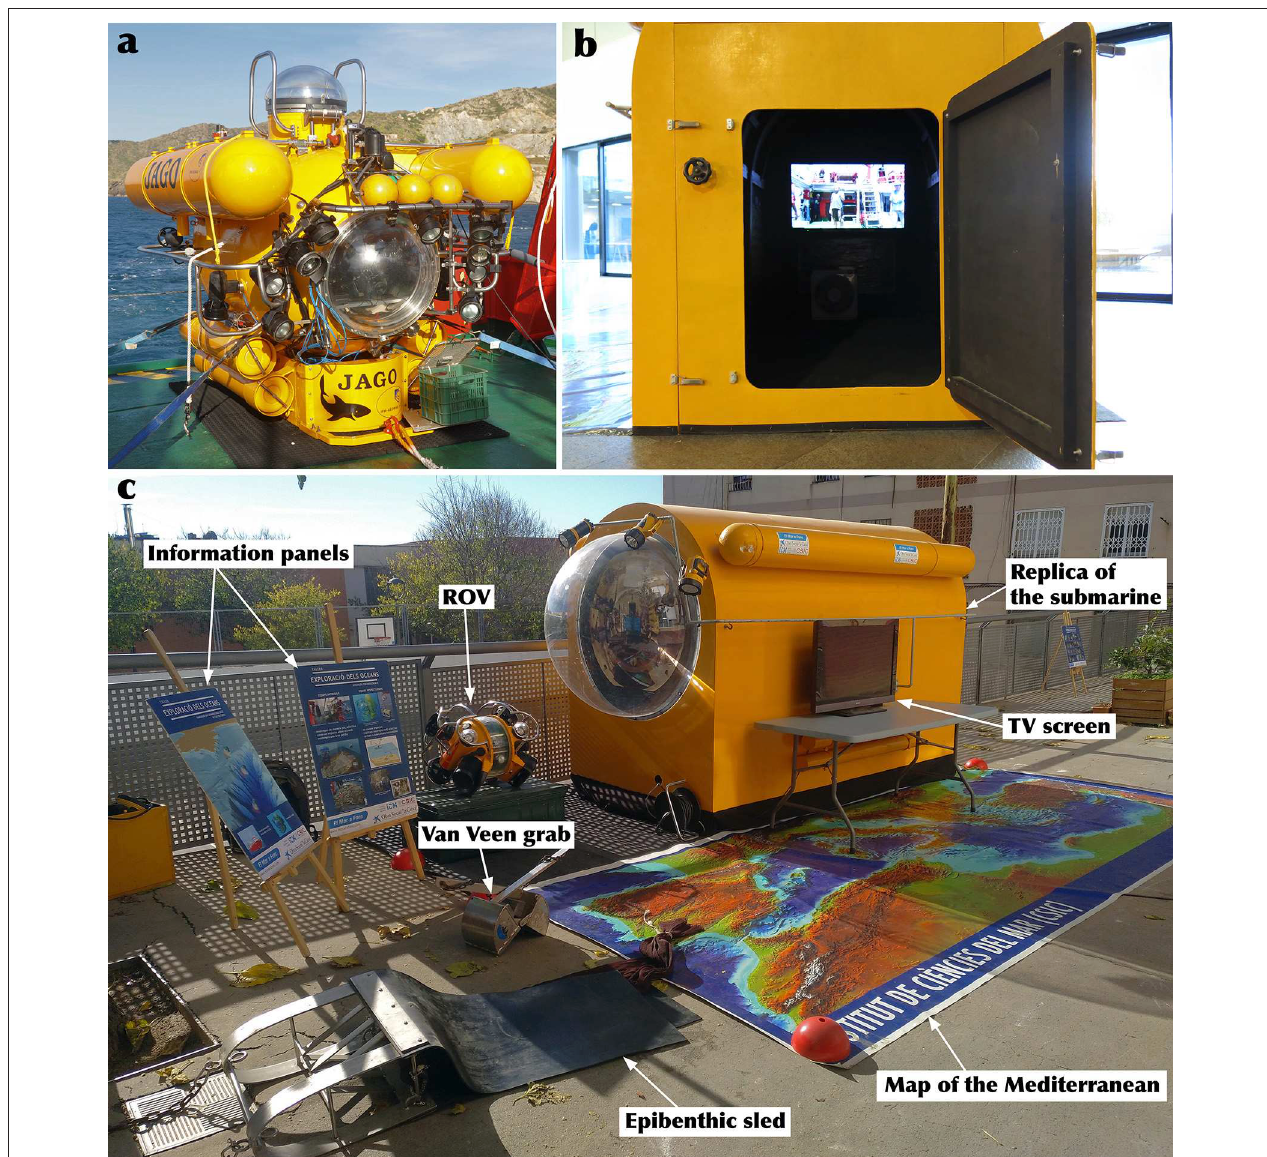
FIGURE 1 | Inspiration and composition of the workshop “Ocean exploration | Dive in a submarine: There is also life in the darkness”: (a) Image of the manned submersible JAGO (GEOMAR) on board of the R/V Garcia del Cid during one of the INDEMARES surveys in Cap de Creus. (b) Rear view of wooden replica of the submarine, with the smaller door opened showing the screen inside. (c) Aspect of the replica and the layout of the remaining components of the